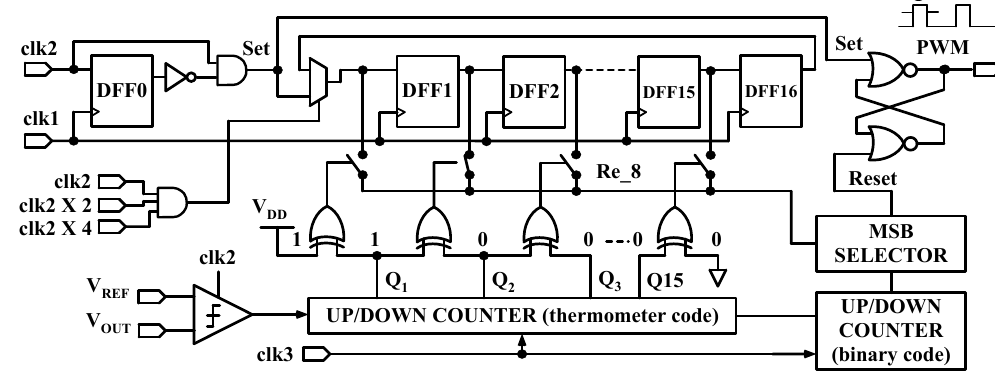
Figure 5. Block diagram of the proposed DPWM.